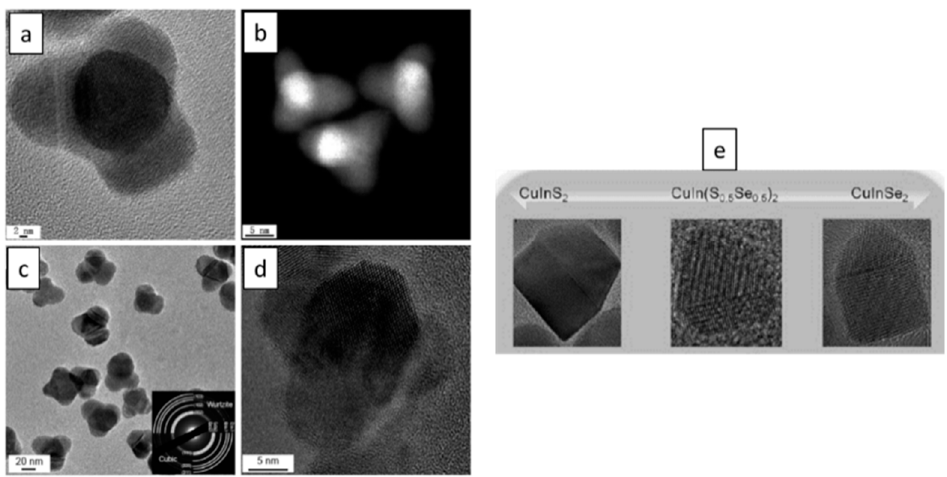
Figure 7. TEM images of Cu-based ternary polytypic quantum dots ( a – d ) Cu 2 SnSe 3 polytypic tetrapods. Reproduced with permission from [136]. Copyright American Chemical Society, 2013. ( e ) CIS, Cu-In-Se-S (CISeS), and CISe polytypic NRs. Reproduced with permission from [135]. Copyright American Chemical Society, 2016.